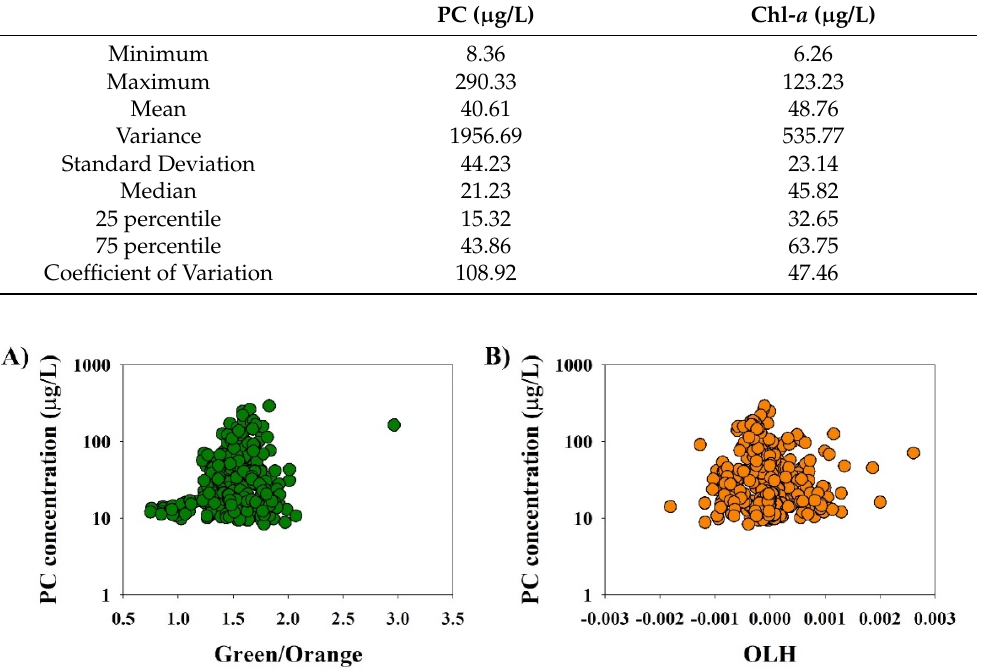
Table 1. Statistical summary for the PC and chl- a concentrations in ECR during the year of 2018.